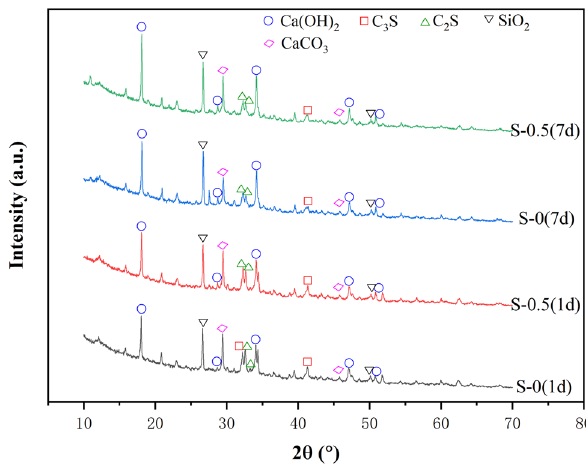
Figure 4: X - ray patterns of hydration products of cement pastes.